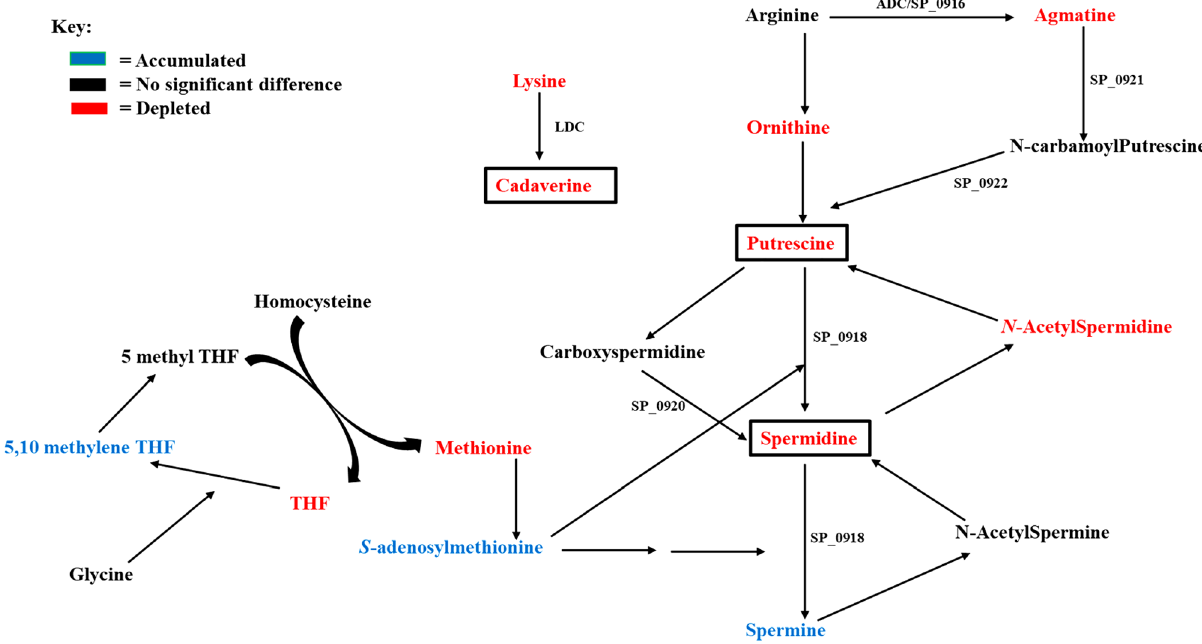
Figure 4. Polyamine biosynthesis pathway and metabolites in TIGR4 as impacted by DFMO. Metabolites in red are depleted, blue are accumulated, while black are not significantly